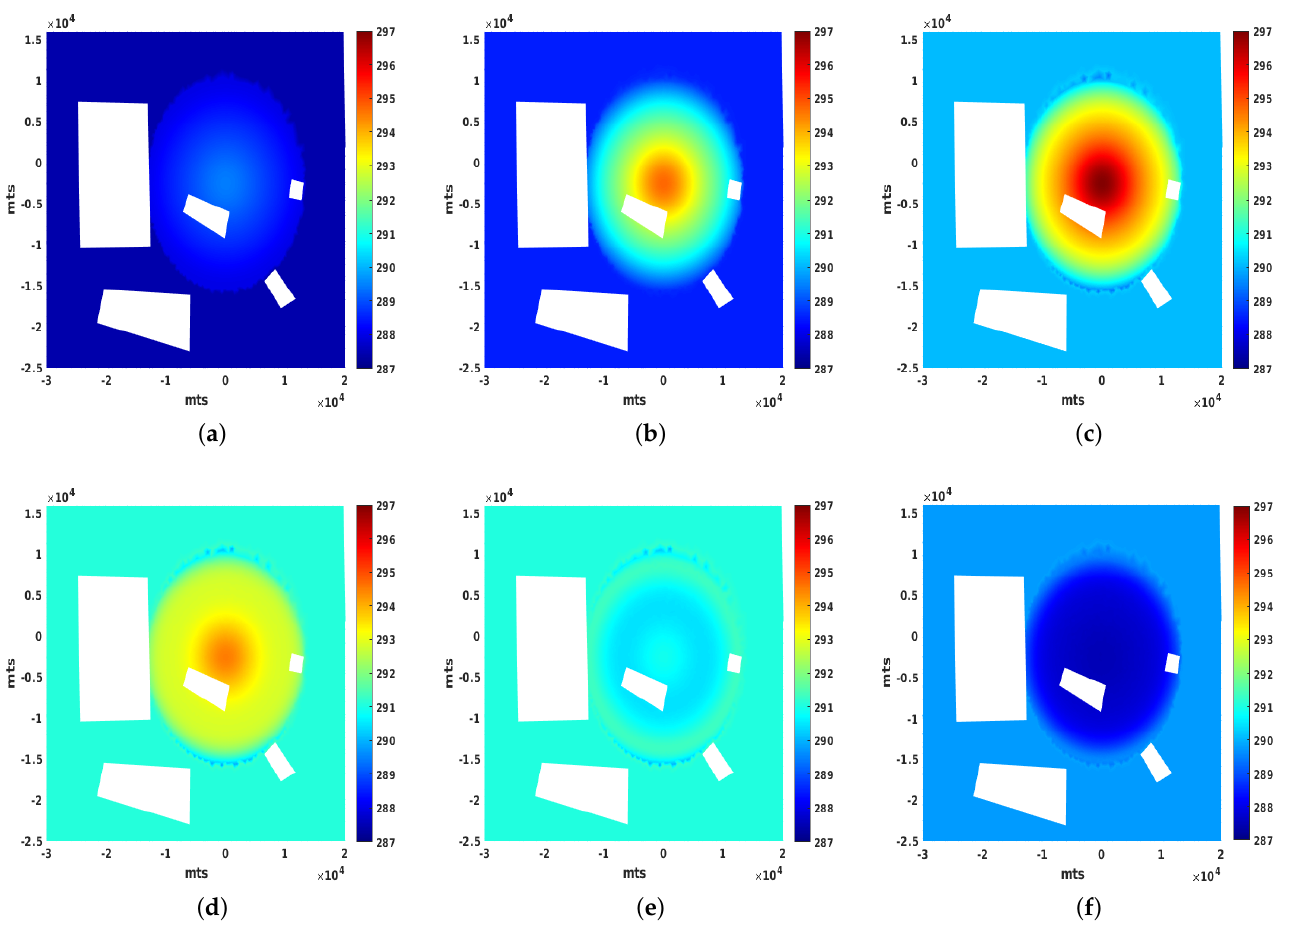
Figure 4. Time evolution of the air temperatures during a 24 h interval. We used the following times 8, 12, 16, and 20 h as a sample to illustrate the obtained results. ( a ) θ a at 8h. ( b ) θ a at 10h. ( c ) θ a at 12h. ( d ) θ a at 14h. ( e ) θ a at 16h. ( f ) θ a at